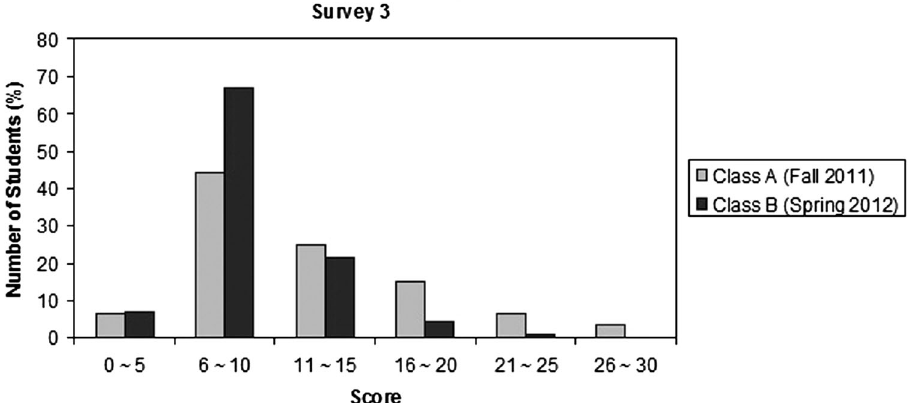
FIG. 8. Students ’ performance on the Survey 3 at two introductory astronomy